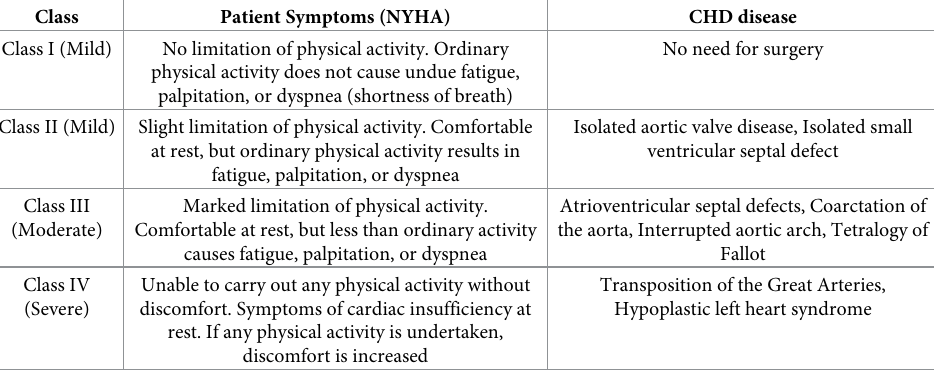
Table 5. Classification of CHD patients into heart failure